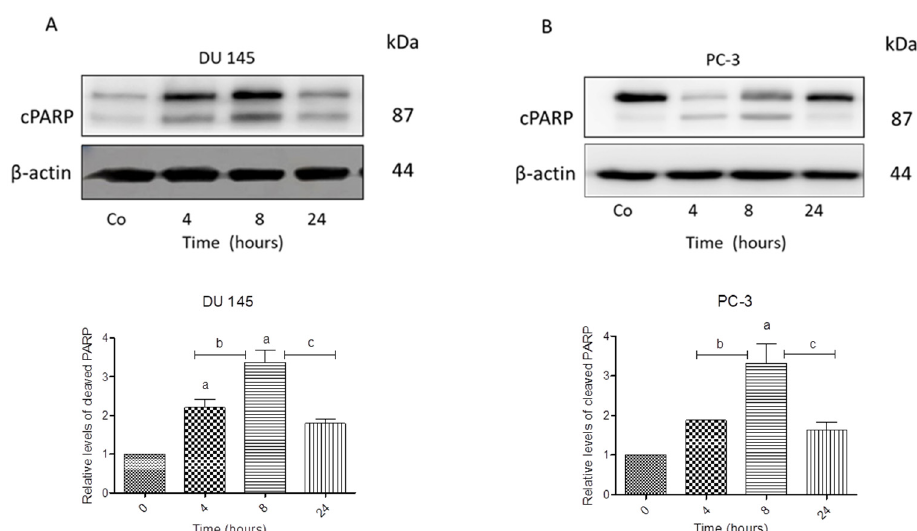
Figure 6. Western blot analysis of cleaved PARP in DU 145 ( A ) and PC-3 cells ( B ) treated with 40 μ M and N -(3-mb)-BS, respectively, for indicated time points. β -actin was used as a lane loading control. The results are presented as mean ± SE of three independent experiments. The statistical significance of differences between respective samples was determined by one-way ANOVA followed by Bonferroni’s multiple comparison test, where (a) indicates significant difference between control and treated N -(3-mb)-BS treated cells P < 0.05.